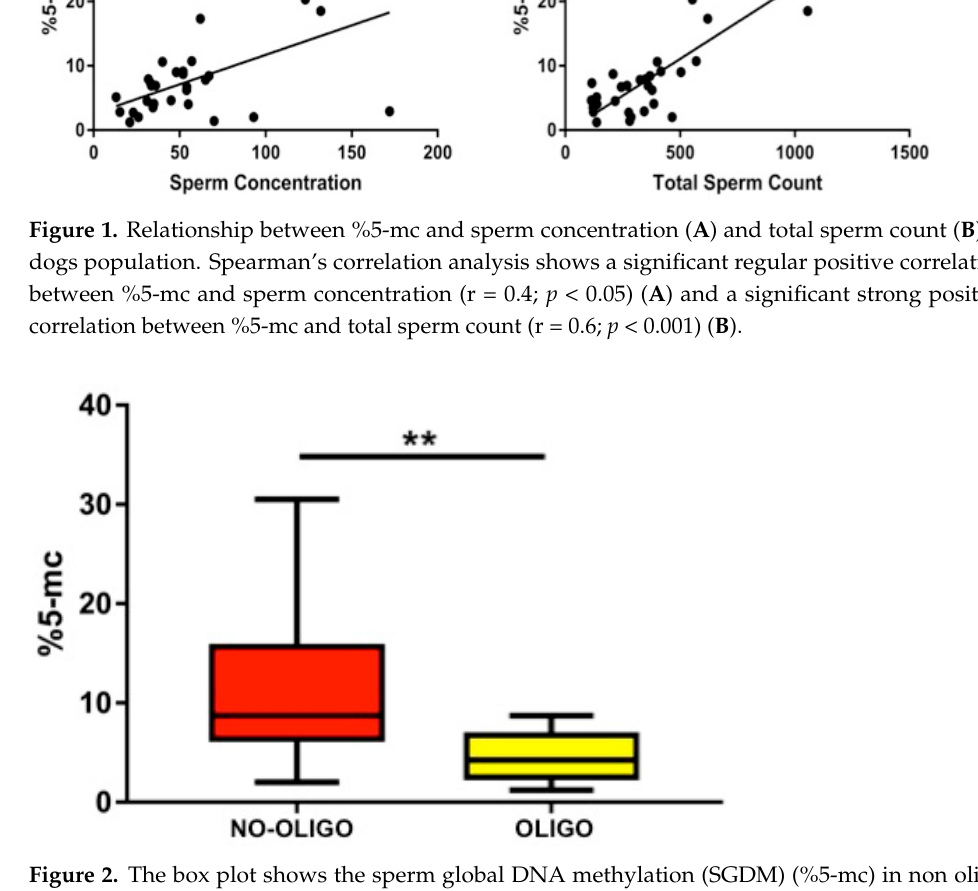
Figure 3. Relationship between %5-mc and sperm concentration ( A , C ) and total sperm count ( B , D ) dividing the samples according to dog’s size: medium sized ( A , B ) and large sized ( C , D ). Spear- man’s correlation analysis shows a significant strong positive correlation between %5-mc and sperm concentration in medium sized dogs (r = 0.6; p < 0.05) ( A ) and large sized dogs (r = 0.4; p < 0.05) ( C ). A significant strong positive correlation between %5-mc and total sperm count was found in large sized dogs (r = 0.7; p <0.0001) ( D ). Figure 4. Histogram showing the SGDM (%5-mc) in non oligozooospermic/oligozoospermic dogs, dividing the samples according to dog’s size. NO-OLIGIO: Non oligozoospermic; OLIGO: Oligo- zoospermic. Medium sized dogs ( A ) show no significant differences. Large sized dogs ( B ) show a significant difference (** p < 0.005). 4. Discussion Defects of SGDM level have been related in humans and in animal models (i.e., ro- dents) to sperm DNA damage and defective spermatogenesis [18,47]. Houshdaran et al. [48] reported that poor semen quality samples displayed an abnormal global DNA sperm hyper-methylation, as assessed by the analysis of repetitive elements, and locus-specific sperm DNA at imprinted and non-imprinted genes. Conversely, the majority of studies showed an abnormally reduced SGDM in poor semen quality samples. Most studies